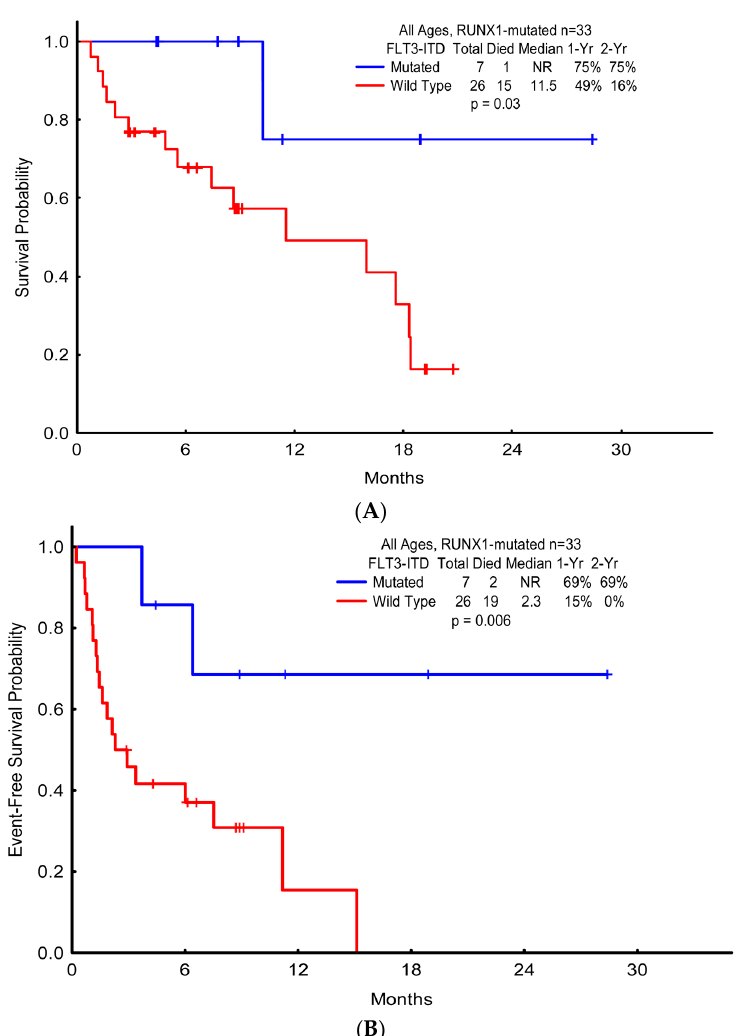
Figure 2. Survival probabilities of patients with RUNX1 and FLT3-ITD mutations. ( A ) Overall survival; ( B ) Event-free survival.